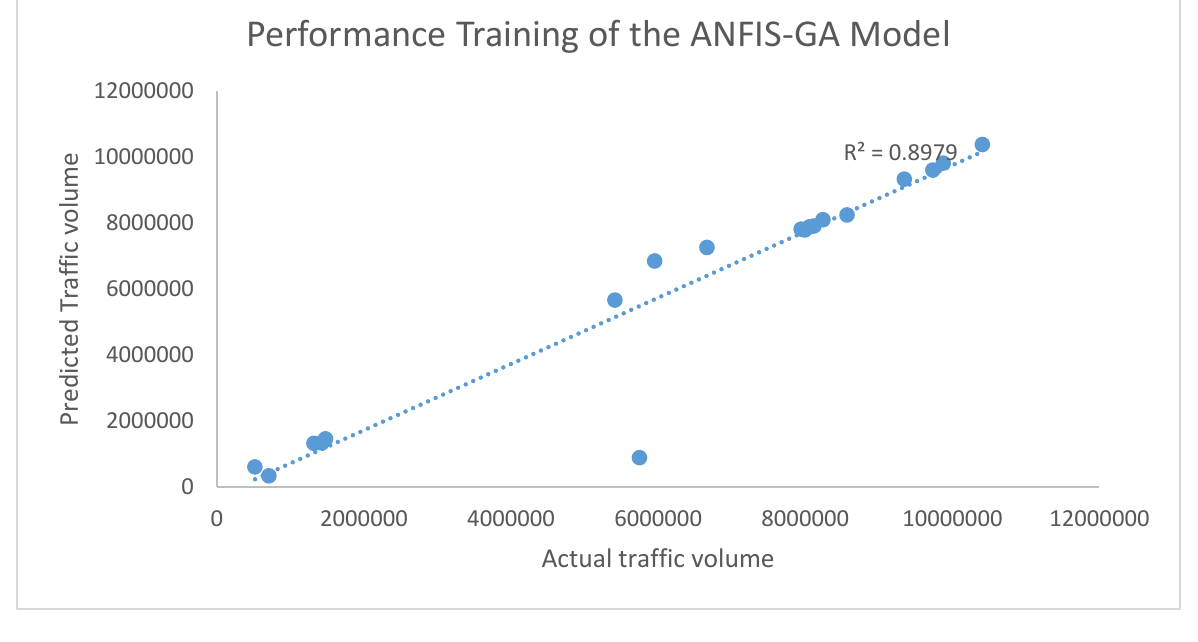
Figure 15. ANFIS-GA model training.